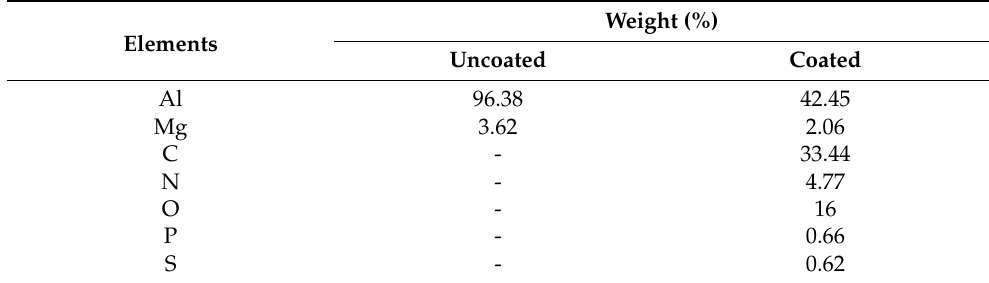
Figure 5. Photo of surface morphology and elements analysis of metal composition of AA5052 chitosan coated using SEM-EDX. Table 5. Elements composition of metallic surface AA5052 uncoated and coated with chitosan inhibitor coating.